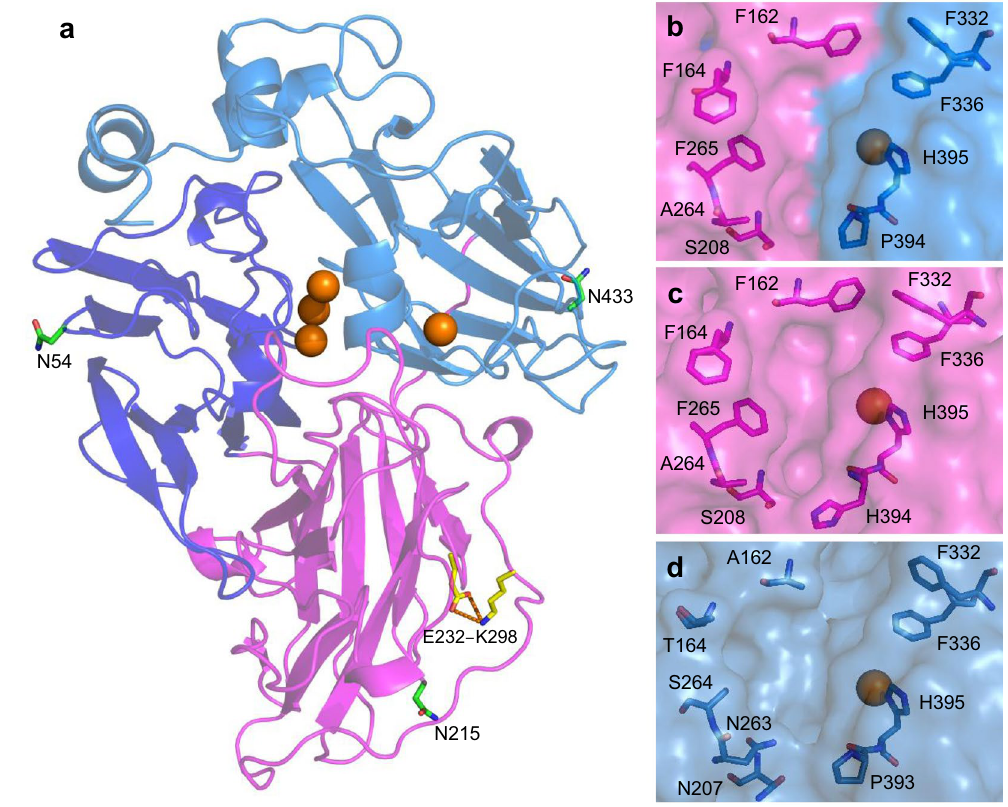
Figure 1. Structure model of domain-swap laccase. ( a ) Cartoon representation showing N-glycosylation sites as green sticks and putative salt bridge inherited from 3PO-D2 as yellow sticks. D1 and D3, inherited from OB1, are shown in dark and light blue, respectively. D2, inherited from 3PO, is shown in magenta. Catalytic coppers are shown as spheres. ( b – d ) Close-ups of the substrate binding pockets of domain-swap laccase ( b ), 3PO ( c ) and OB1 ( d ). Residues delimiting the substrate binding pocket are shown as